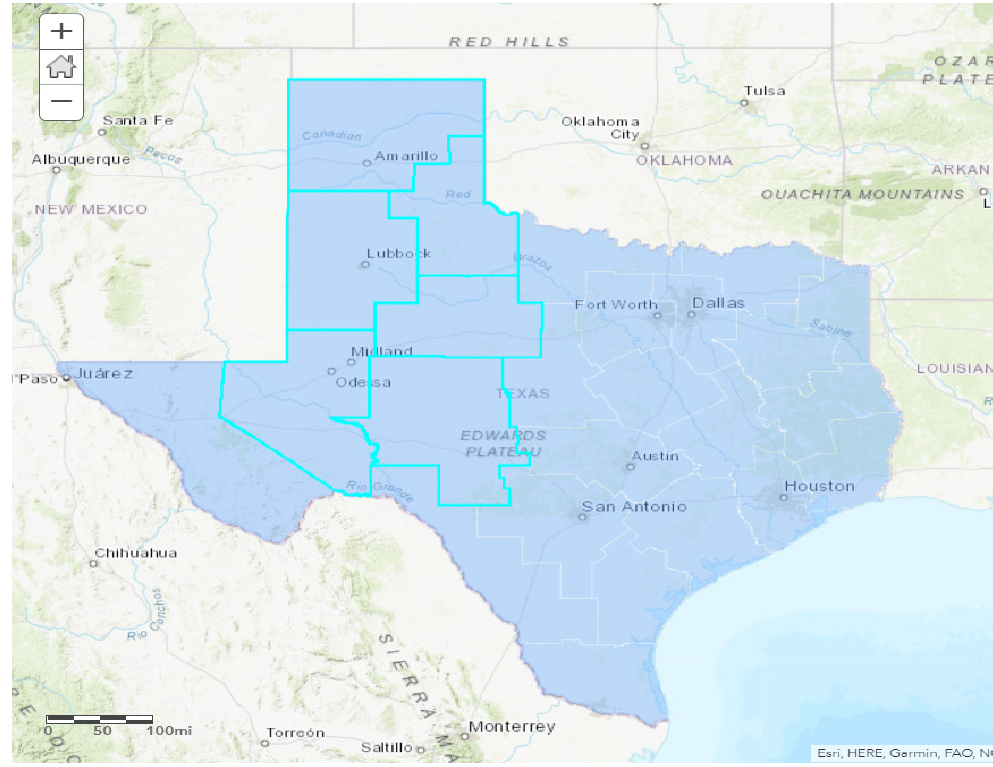
Figure 1. Study area: Five Texas Department of Transportation (TxDOT) districts in the West Texas rural area.